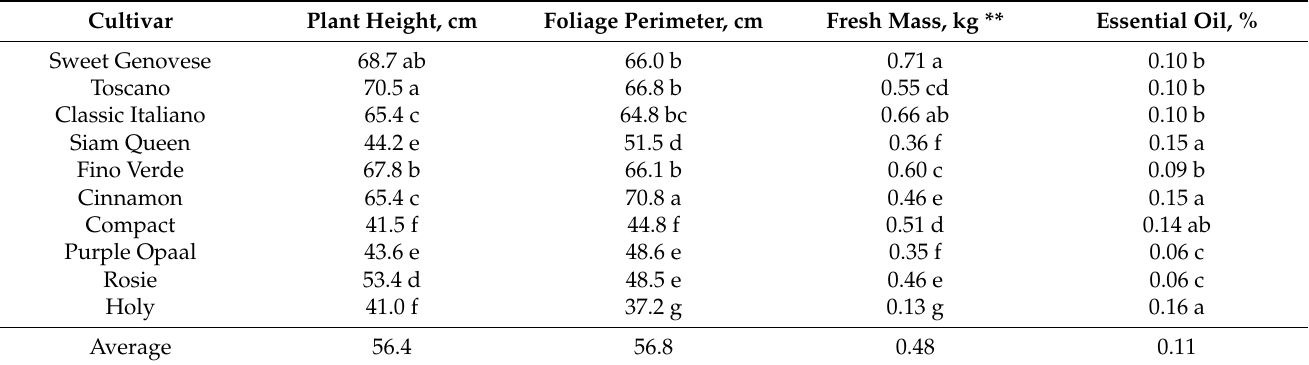
Table 5. Morphological futures, fresh mass, and amount of essential oil of different basil cultivars *.